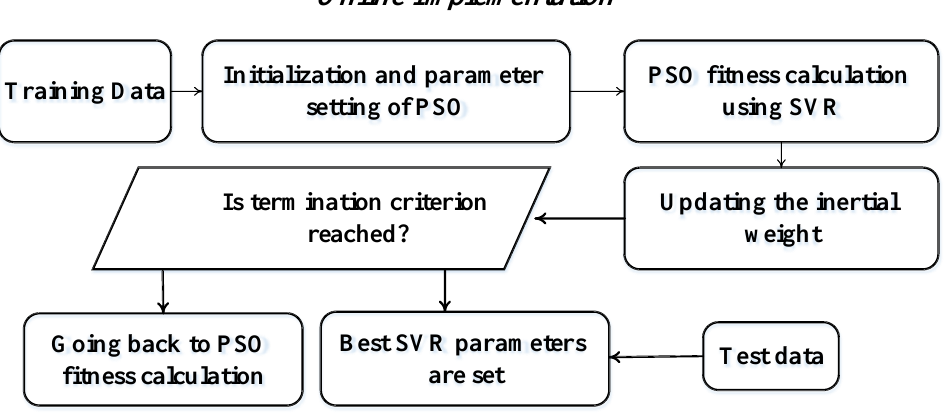
Figure 5. Implementation process diagram.